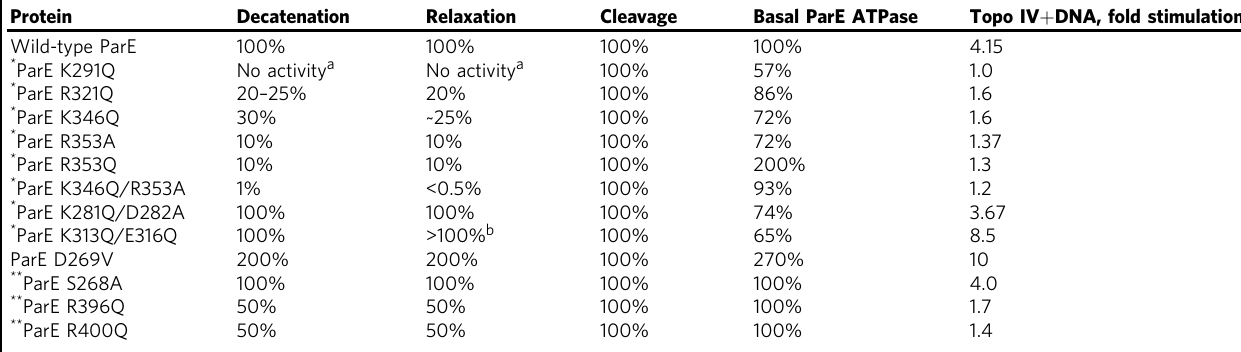
Table 2 Activities of wild-type and mutant topo IV enzymes Protein